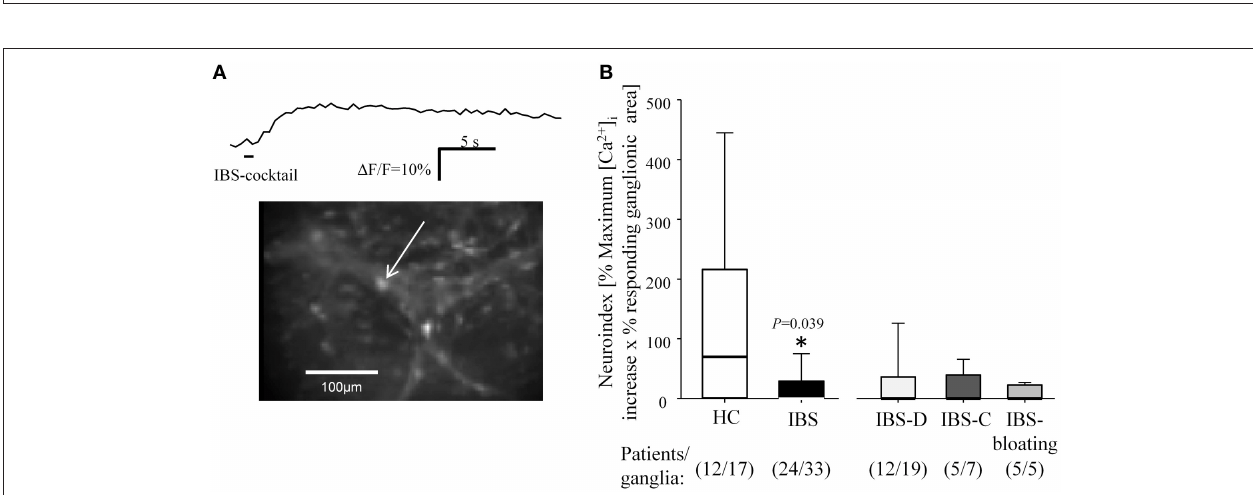
FIGURE 2 | Neuronal response to electrical stimulation of interganglionic fiber tracts. (A) Submucous ganglion stained with the calcium-sensitive dye Fluo-4 AM. The trace reflects [Ca 2 + ] i transients in response to electrical stimulation in the cell marked by the white arrow. (B) Electrical stimulation evoked comparable increases in the neuroindex in IBS and HC biopsies as well as between IBS subgroups.